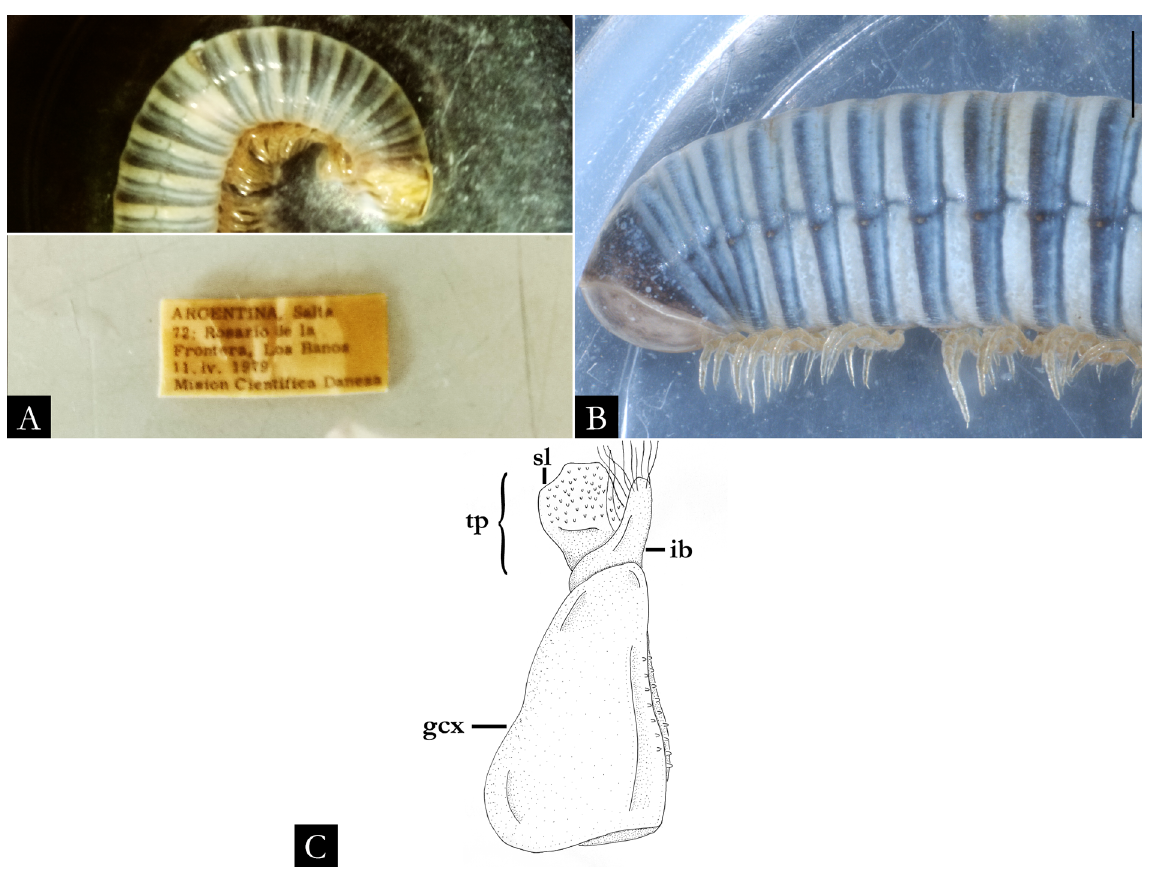
Fig. 131. Pseudonannolene sulcatula Silvestri, 1895, ♀ (NHMD). A . Body rings, in lateral view, and original label. B . Posterior region in lateral view. C . Schematic drawing of right gonopod in anal view (modified from Silvestri 1895b: fig. 14). Abbreviations: see Material and methods. Images not to scale.